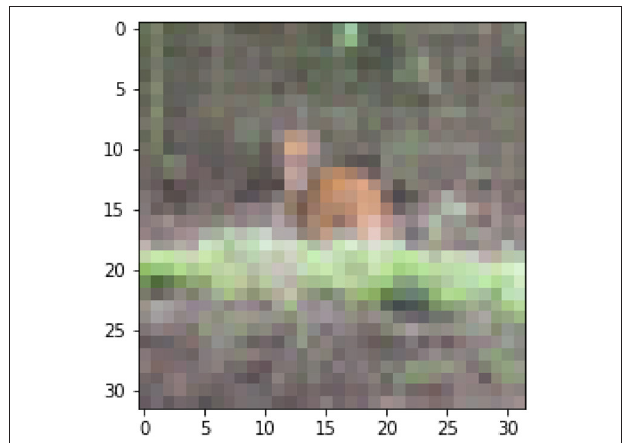
FIGURE 2 | An example of disagreement from CIFAR10H Ground truth label: deer , crowd annotations: [ dog :33, deer :13, horse